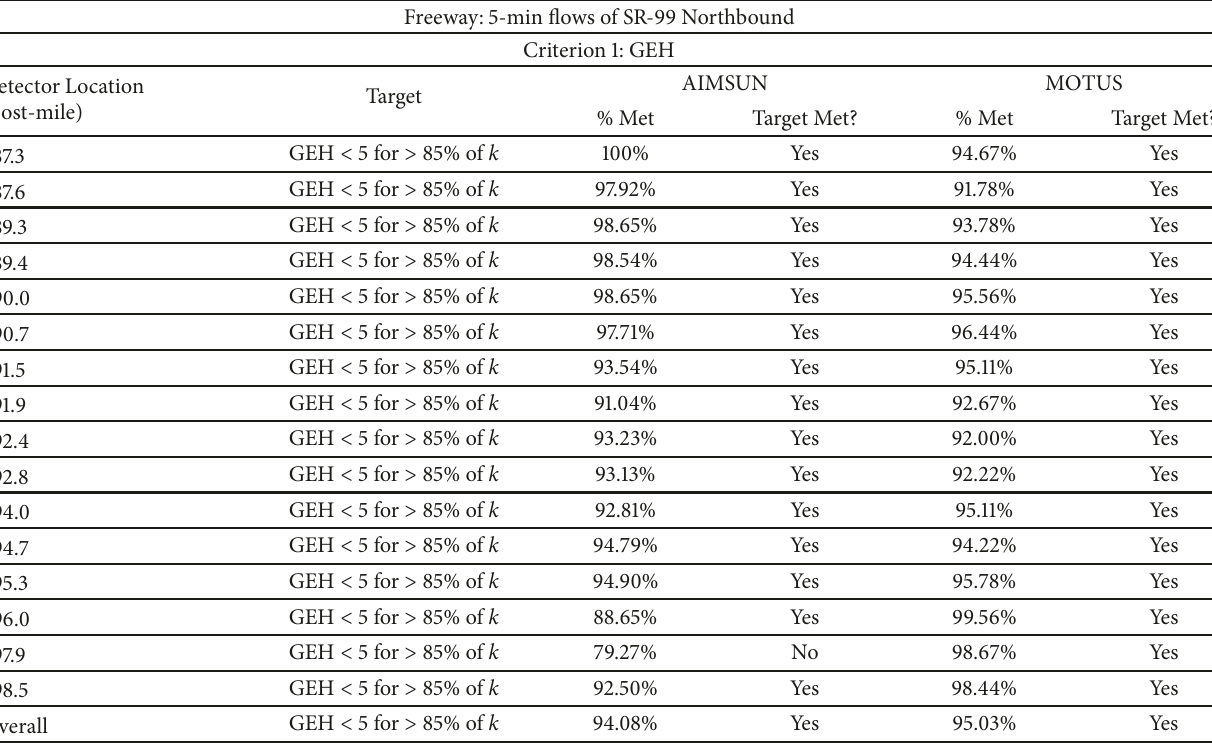
Table 3: Calibration of freeway flows under GEH criterion.